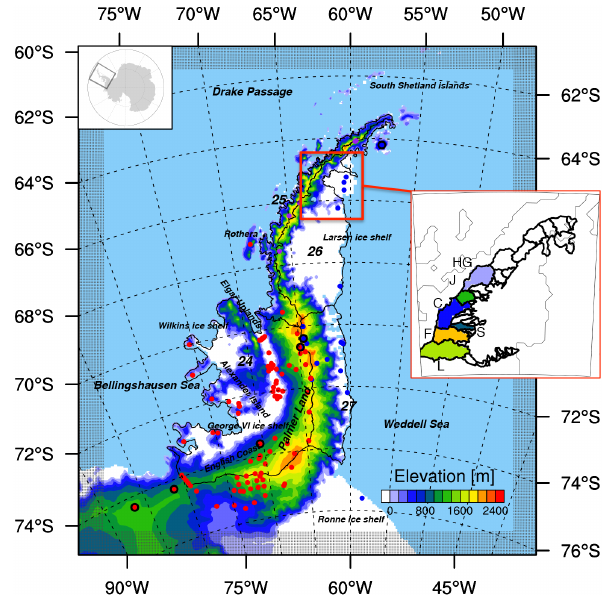
Figure 1. RACMO2.3 Antarctic Peninsula model domain (black box in inset map of Antarctica), boundary relaxation zone (dotted area, 16 grid points) and model surface topography (m). Locations of in situ SMB observations are marked (dots); ice cores, as used in Sect. 3.2, are highlighted (black circles). Colours of the dots in- dicate whether the observation lies in a WAP (red), EAP (blue) or spine (purple) height bin (see Sect. 3). Model topography is based on digital elevation models from Cook et al. (2012) for the region north of 70 ◦ S, and Bamber et al. (2009) south of 70 ◦ S. White ar- eas represent floating ice shelves, colours represent the elevation of the grounded ice sheet. Zwally et al. (2012) drainage basins 24, 25, 26 and 27 are shown (black lines). One EAP in situ ob- servation is shown in light blue for visibility. Inset denotes the six drainage basins of pre-acceleration Larsen B outlet glaciers: Star- buck (S), Flask (F), Leppard (L), Crane (C), Jorum (J) and Hektoria- Green (HG) from Wuite et al.